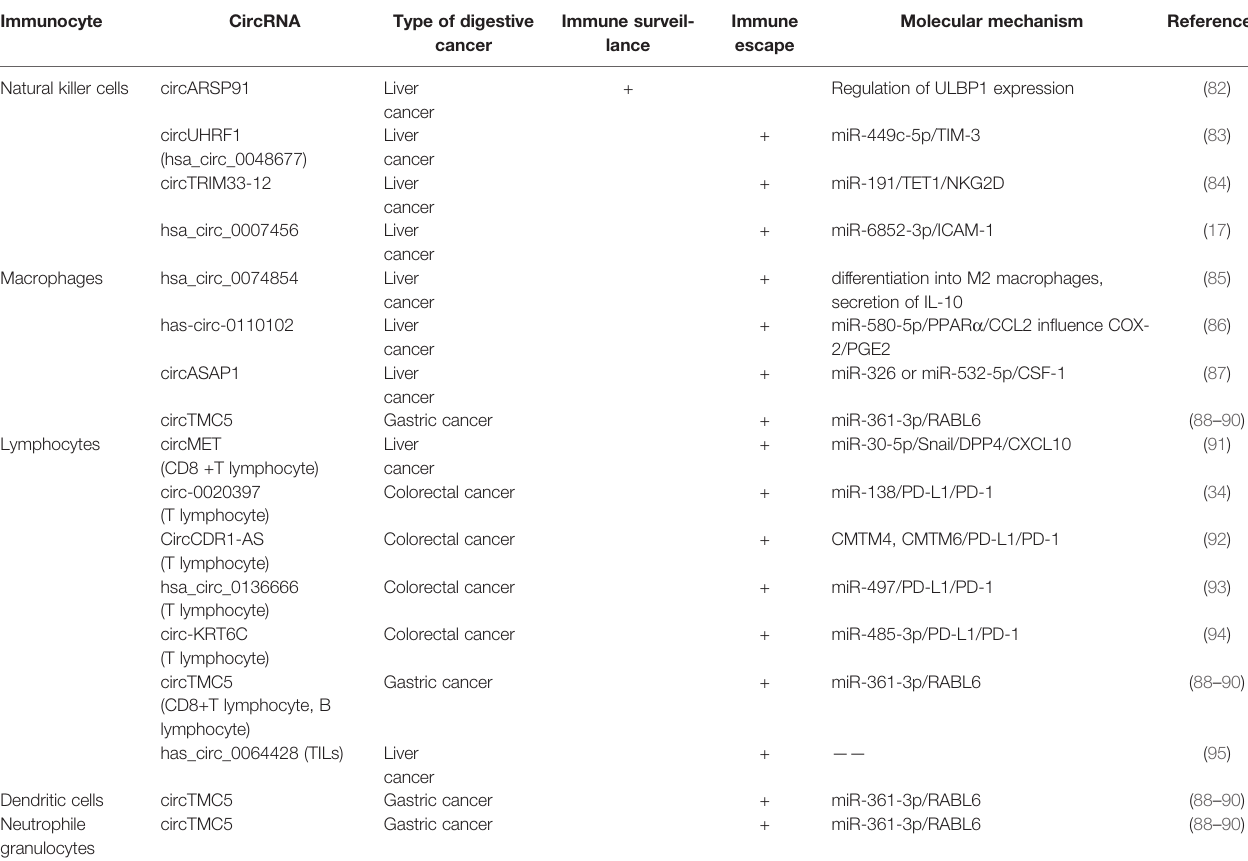
TABLE 2 | CircRNA involved in the immune regulation of various types of digestive